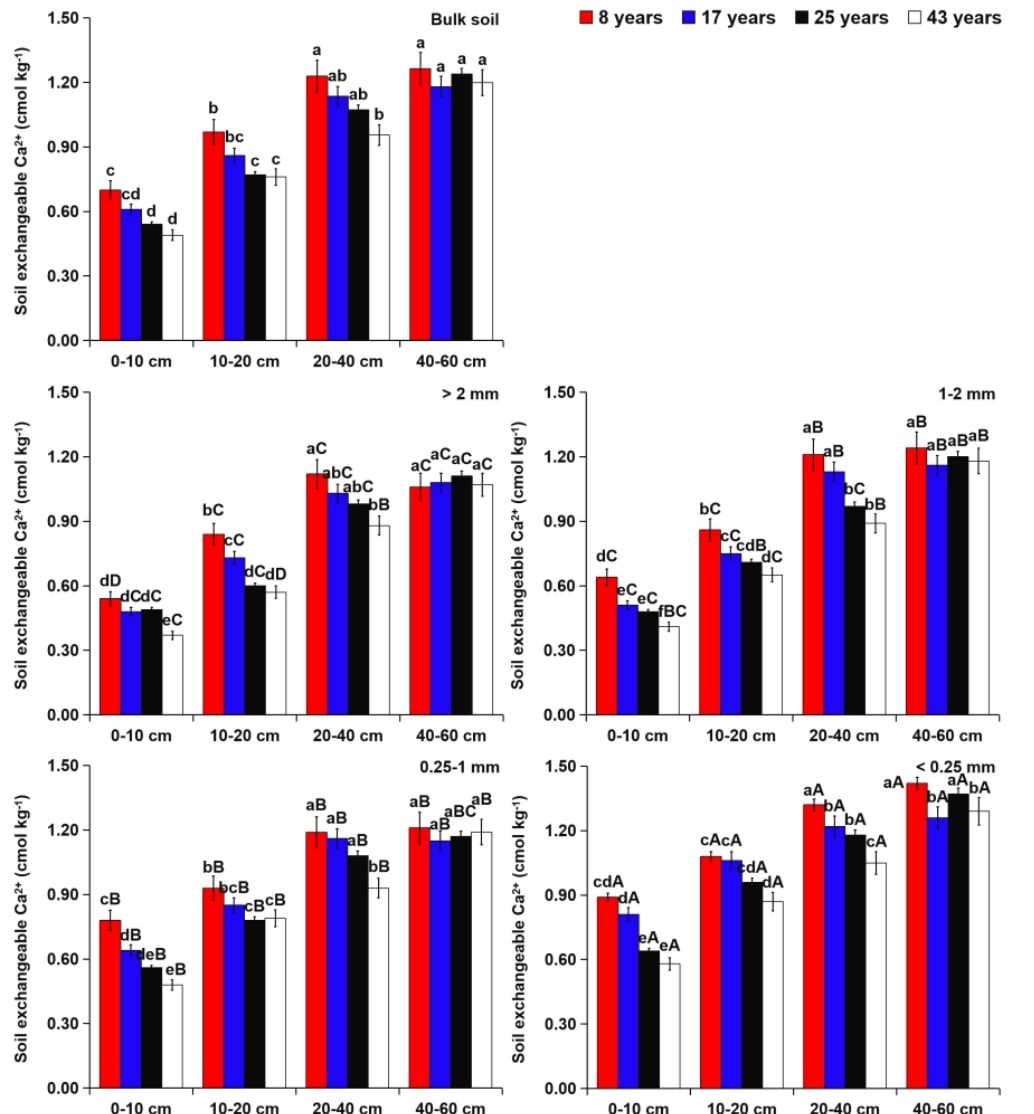
Figure 5. Effects of soil depth and tea plantation age on the exchangeable Ca 2 + content in bulk soil and different-sized aggregates. Data rep- resent the mean of five replicates, and error bars represent the standard deviations. Means with the same lowercase letter are not significantly different ( p > 0 . 05) among different soil depths and tea plantation ages. Means with the same capital letter are not significantly different ( p > 0 . 05) among different-sized